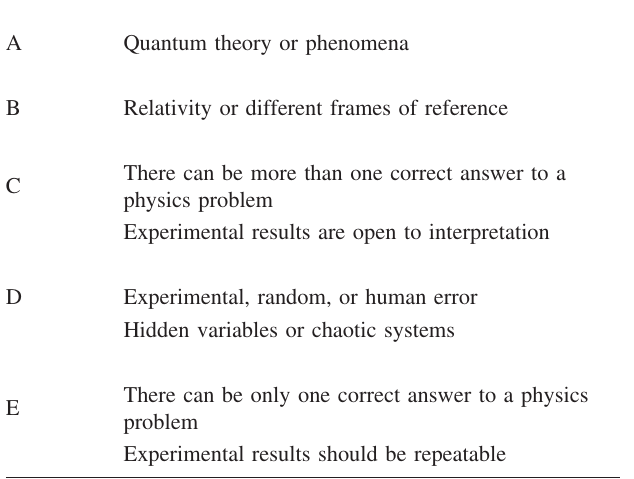
TABLE I. Categorization of concepts invoked by students in response to CLASS No.